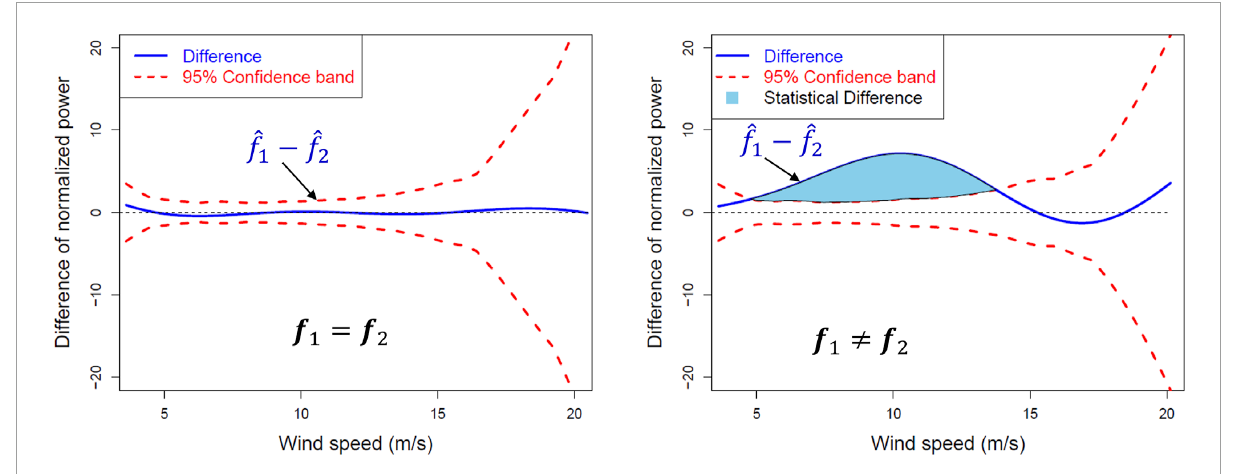
FIGURE 1 Power functional curve comparison and uncertainty quantification.